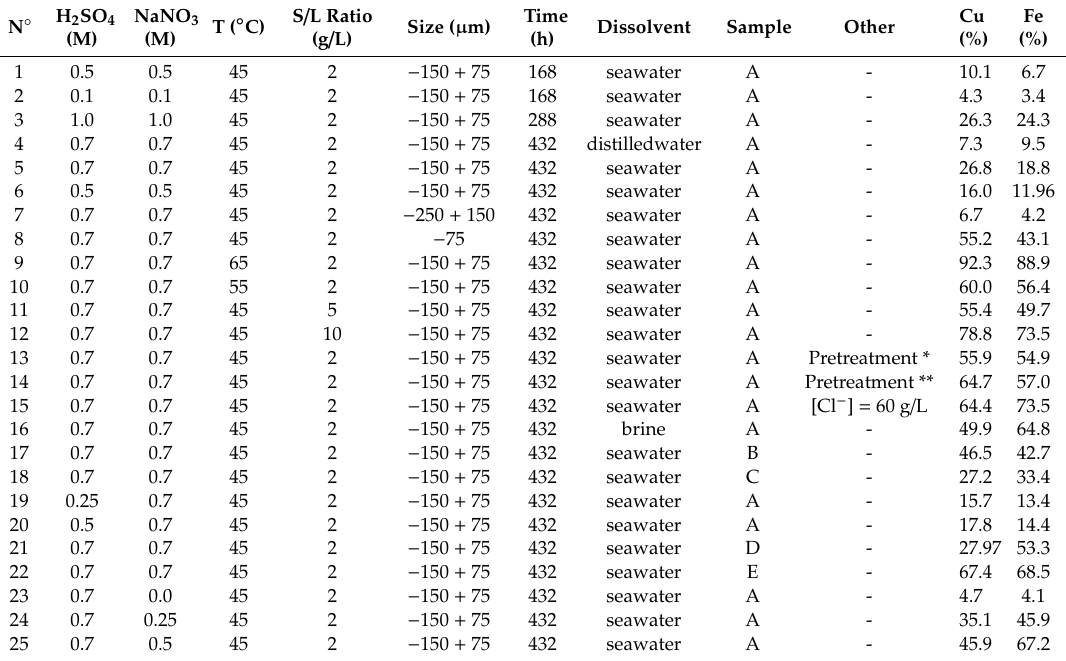
Table 4. Leaching test parameters with metal extraction